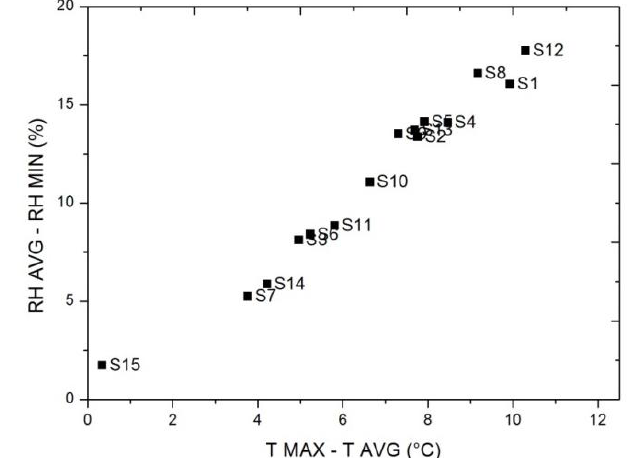
Figure 11. Bivariate plot of temperature (horizontal axis) versus RH (vertical axis), of the difference between the average before the heating system is switched on (2 h) and the maximum (minimum for RH) when it is working (from 2/1/2012 to